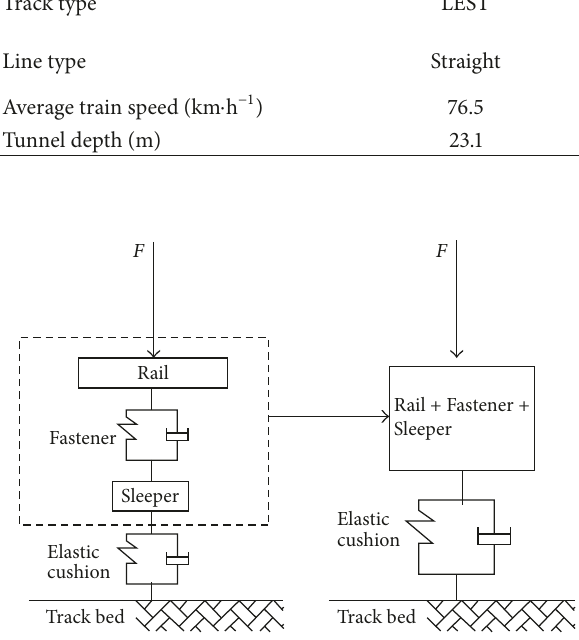
Figure 2: Mass-spring-damper system of LEST